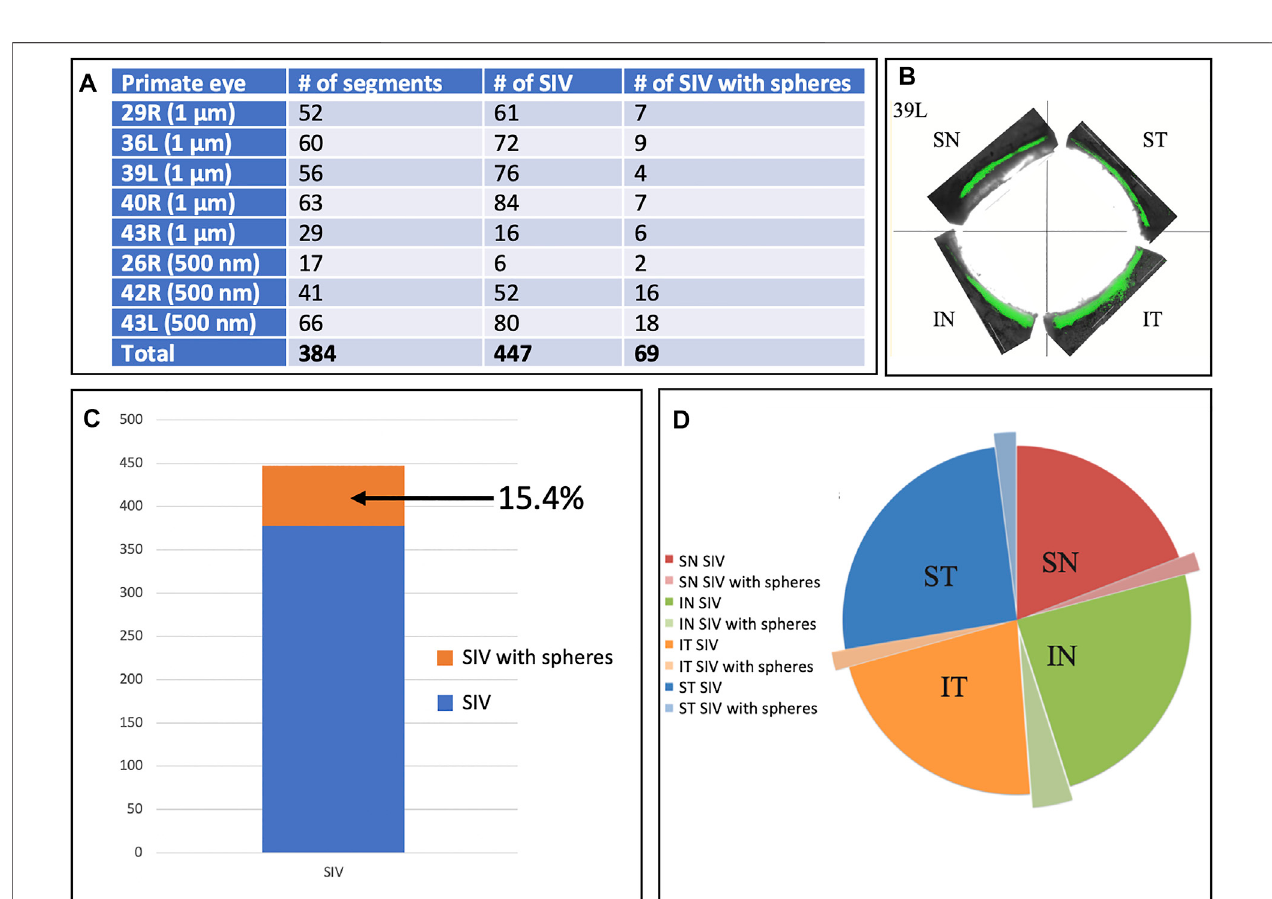
FIGURE 6 | Schlemm ’ s canal inner wall valve-like structure frequency and microsphere presence. (A) Eight primate eyes were perfused with 1 and 500 nm fl uorescent microspheres.The entirecircumferenceofeach eyewasdividedinto250 – 500 µm segments.The total number ofSchlemm ’ scanal(SC) inner wall valve-like structures (SIV) in each segment and those containing microspheres were recorded. The mean number of the SIV/segment was 1.16 ± 0.38. (B) Light microscopy demonstrates the distribution of 1-µm fl uorescent (green) microspheres in each quadrant in one eye. (C) Chart demonstrates the percentage of SIV with microspherescompared tothetotaldocumentedSIV inthefoureyes. (D) PiechartshowsthetotalSIV ineach quadrant. Thechartalso showsthosewithmicrospheres in the four eyes where 360 ° of the SC circumference was examined. The microsphere distribution in SIV was similar in each quadrant.